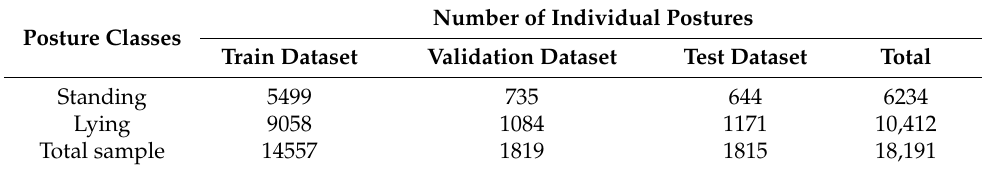
Table 1. Details of posture annotation dataset.